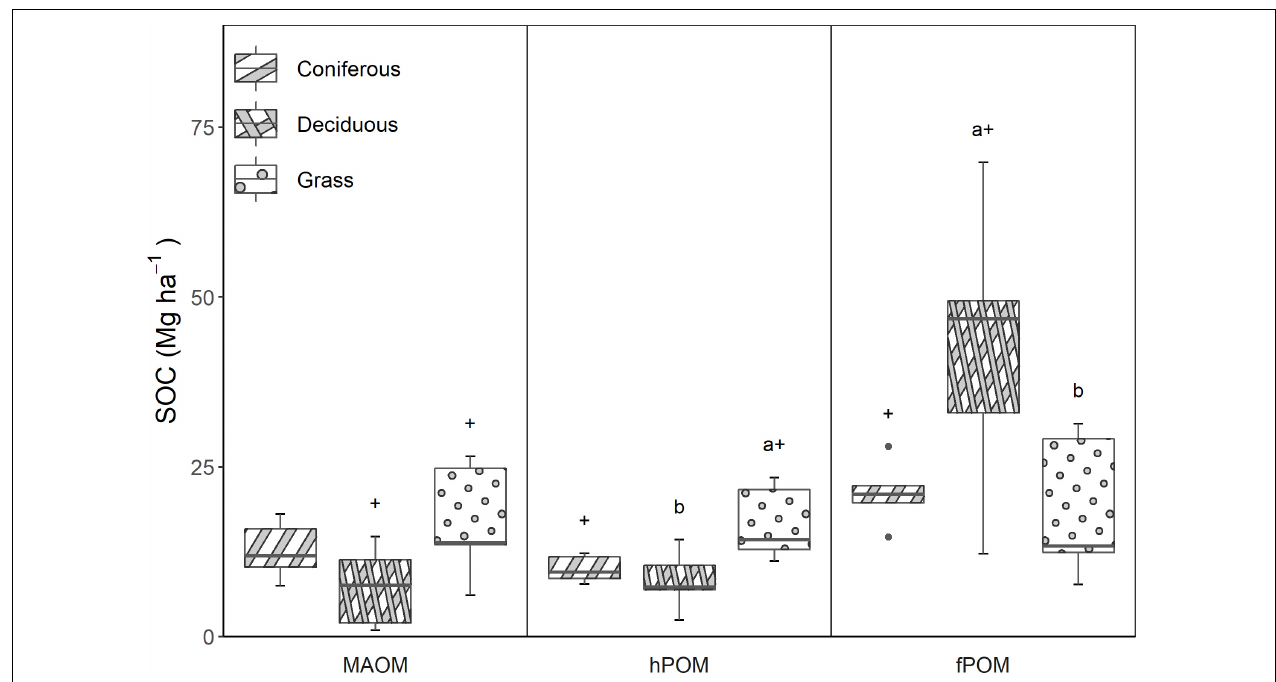
FIGURE 2 | Stocks of soil organic C in MAOM (mineral-associated organic matter), hPOM (heavy particulate organic matter) and fPOM (free particulate organic matter) pools among the three reclaimed vegetation treatments. Significant differences ( p ≤ 0.05) among treatments are noted using a letter above the boxplot, and differences in which p ≤ 0.10 are symbolized using +.